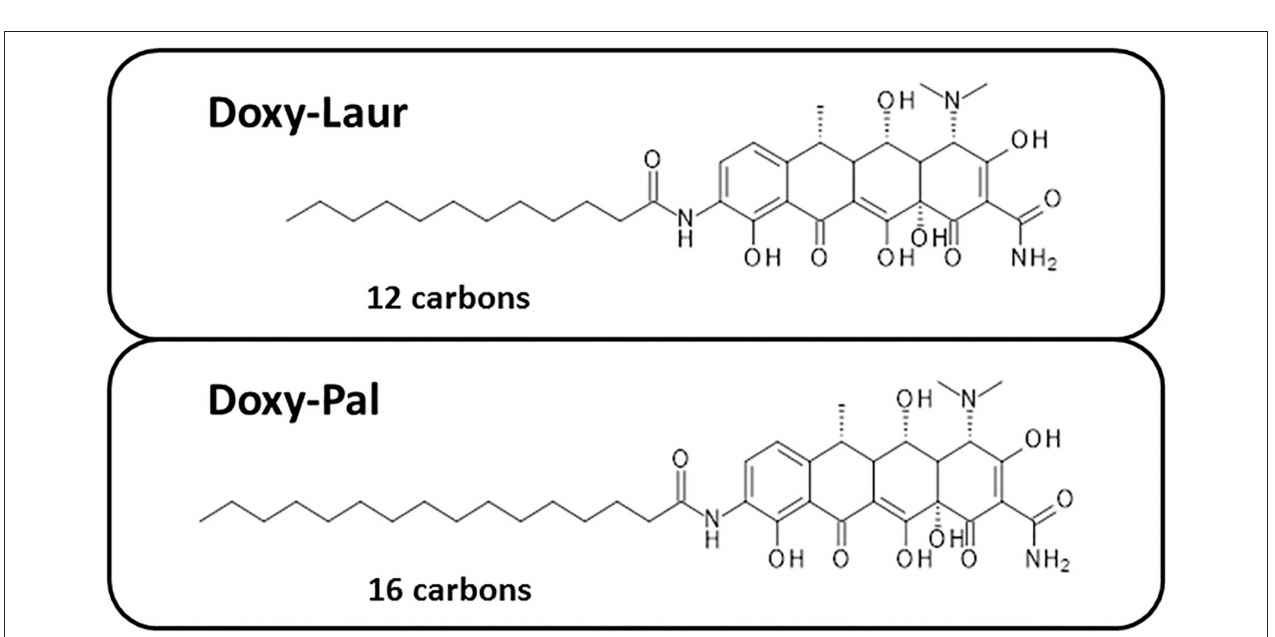
FIGURE 6 | Doxy-Myr does not induce cell cycle arrest, in MCF7 2D-monolayers. MCF7 cells were cultured for 72h as 2D-monolayers, in the presence of Doxycycline or Doxy-Myr, at a concentration of 10 µ M. Vehicle-alone controls were processed in parallel. Note that relative to the parent compound Doxycycline, Doxy-Myr did not have any significant effects on reducing cell cycle progression in 2D-monolayers of MCF7 cells. Representative FACS cell cycle profiles are shown.